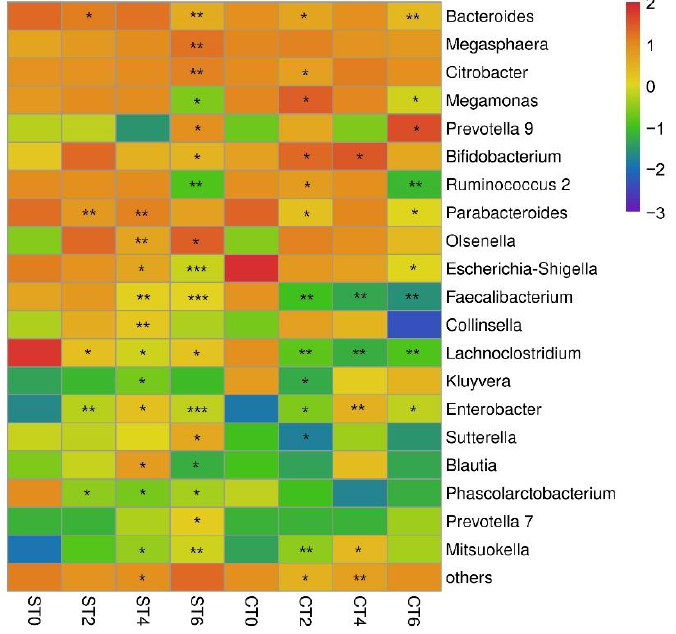
Figure 4. Heatmap of the relative abundance of bacterial genera in the intestinal lumen microbiota (ST—aqueous extract group; CT—alcohol extract group; 0—no sample added; 2, 4, 6 denote fermentation days after sample addition; with no sample added as the control, * p < 0.05, ** p < 0.01, *** p < 0.001).